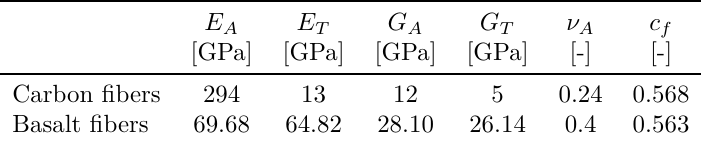
Table 2. Material properties of carbon and basalt fibers and its volume fraction in yarn.